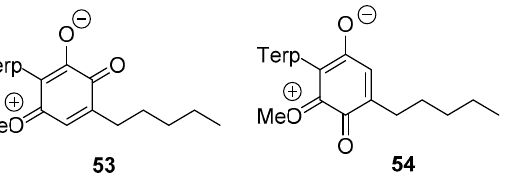
Figure 8. Structure of the zwitterionic resonance for O -methyl- ortho -cannabinoquinones ( 53 ) and O -methyl- para -cannabinoquinones ( 54 ).